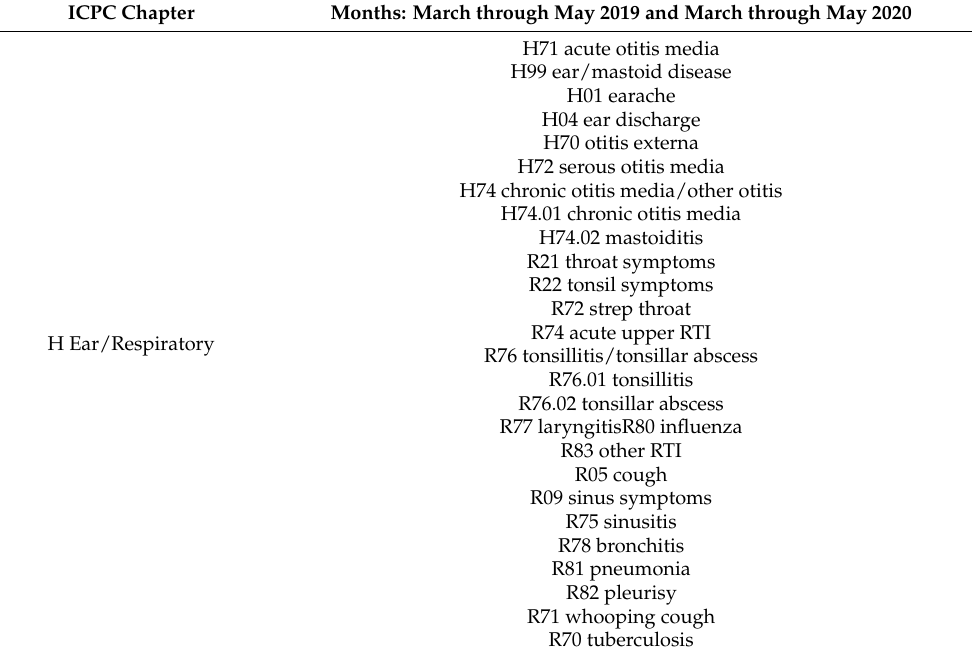
Table A1. International Classification of Primary Care (ICPC) codes used to group consultations into episodes (ear/respiratory, urinary tract, gastrointestinal and skin infection